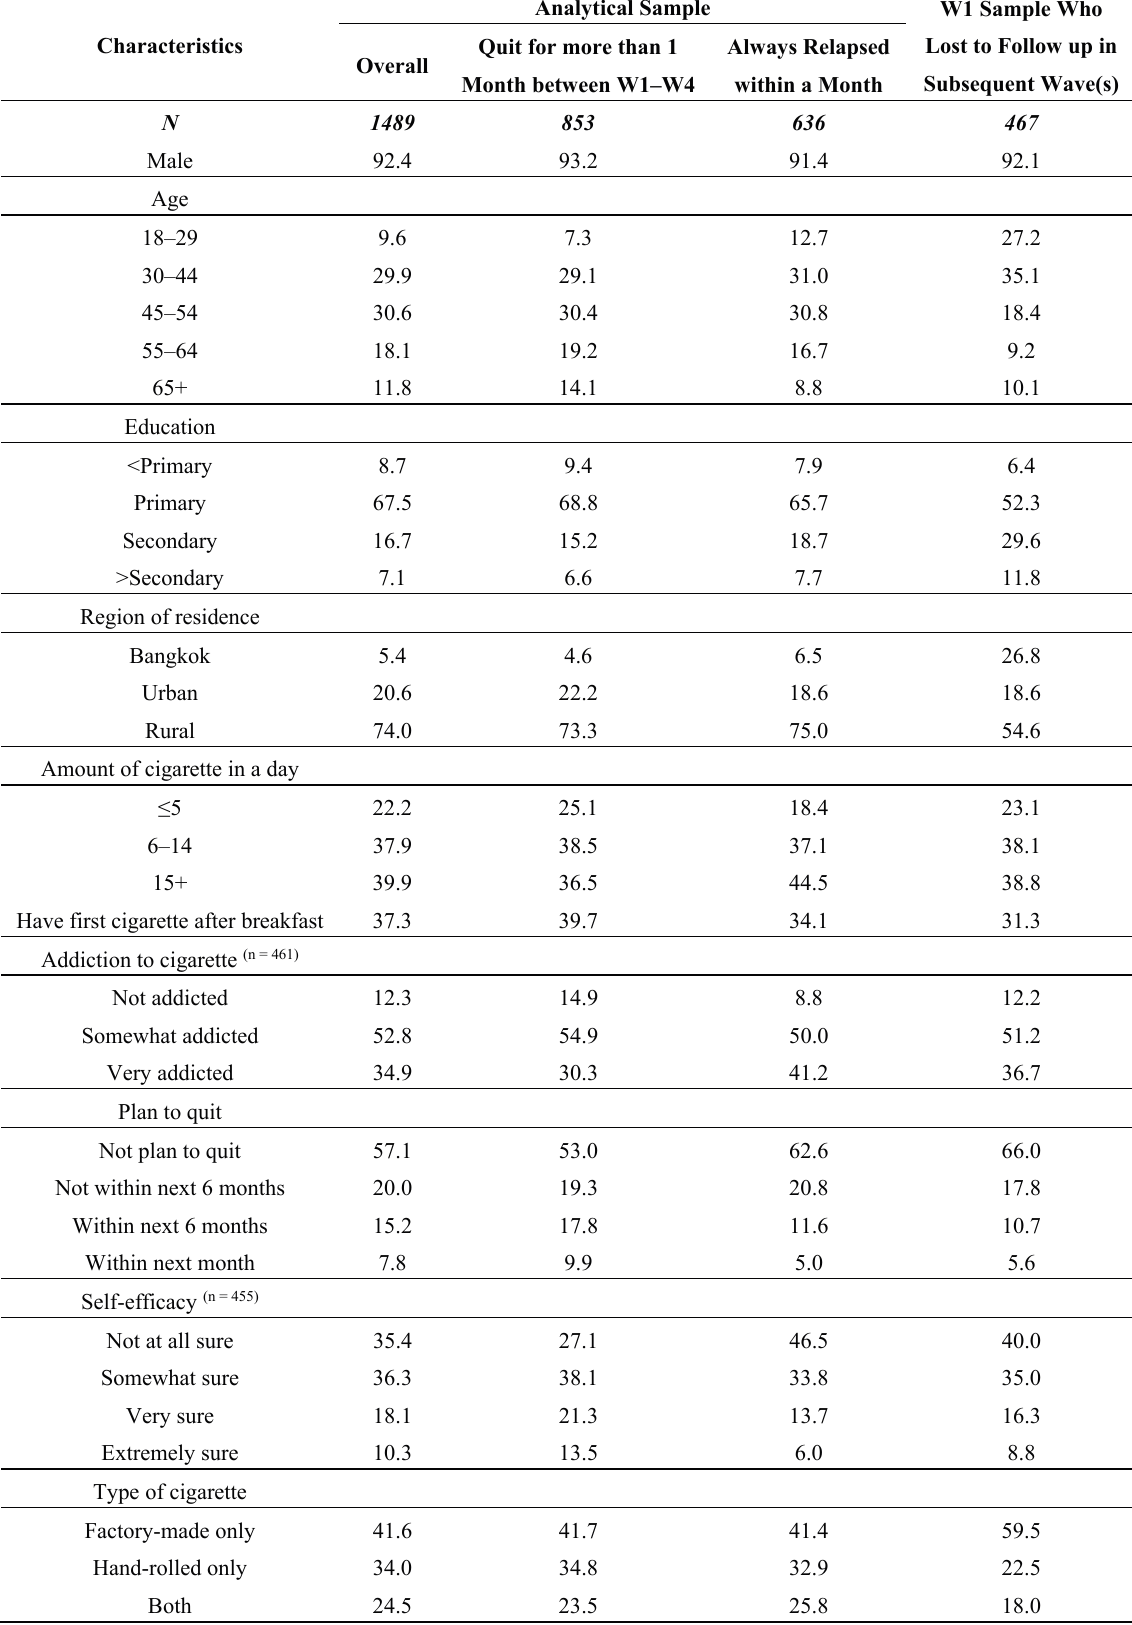
Table 2. Characteristics of the analytical sample (both smokers and those quit for 6 months at W4), compared with the sample lost to